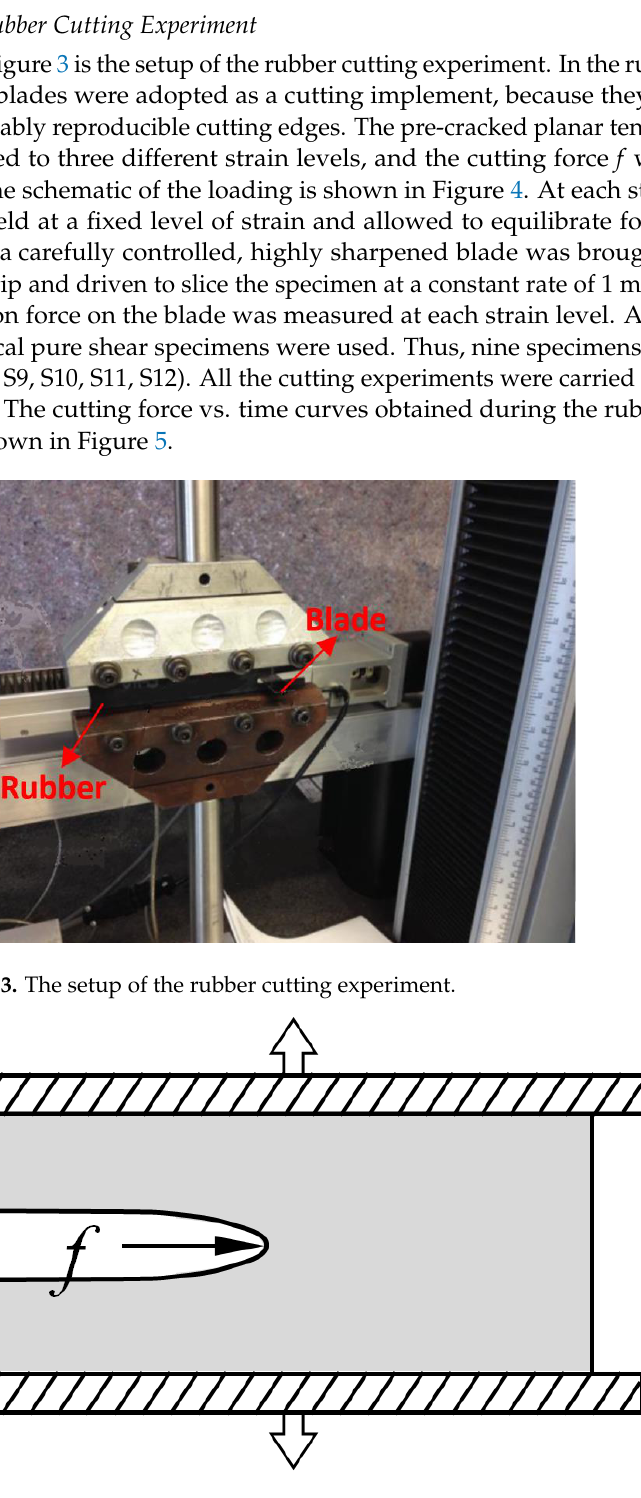
Figure 2. The engineering stress versus engineering strain.